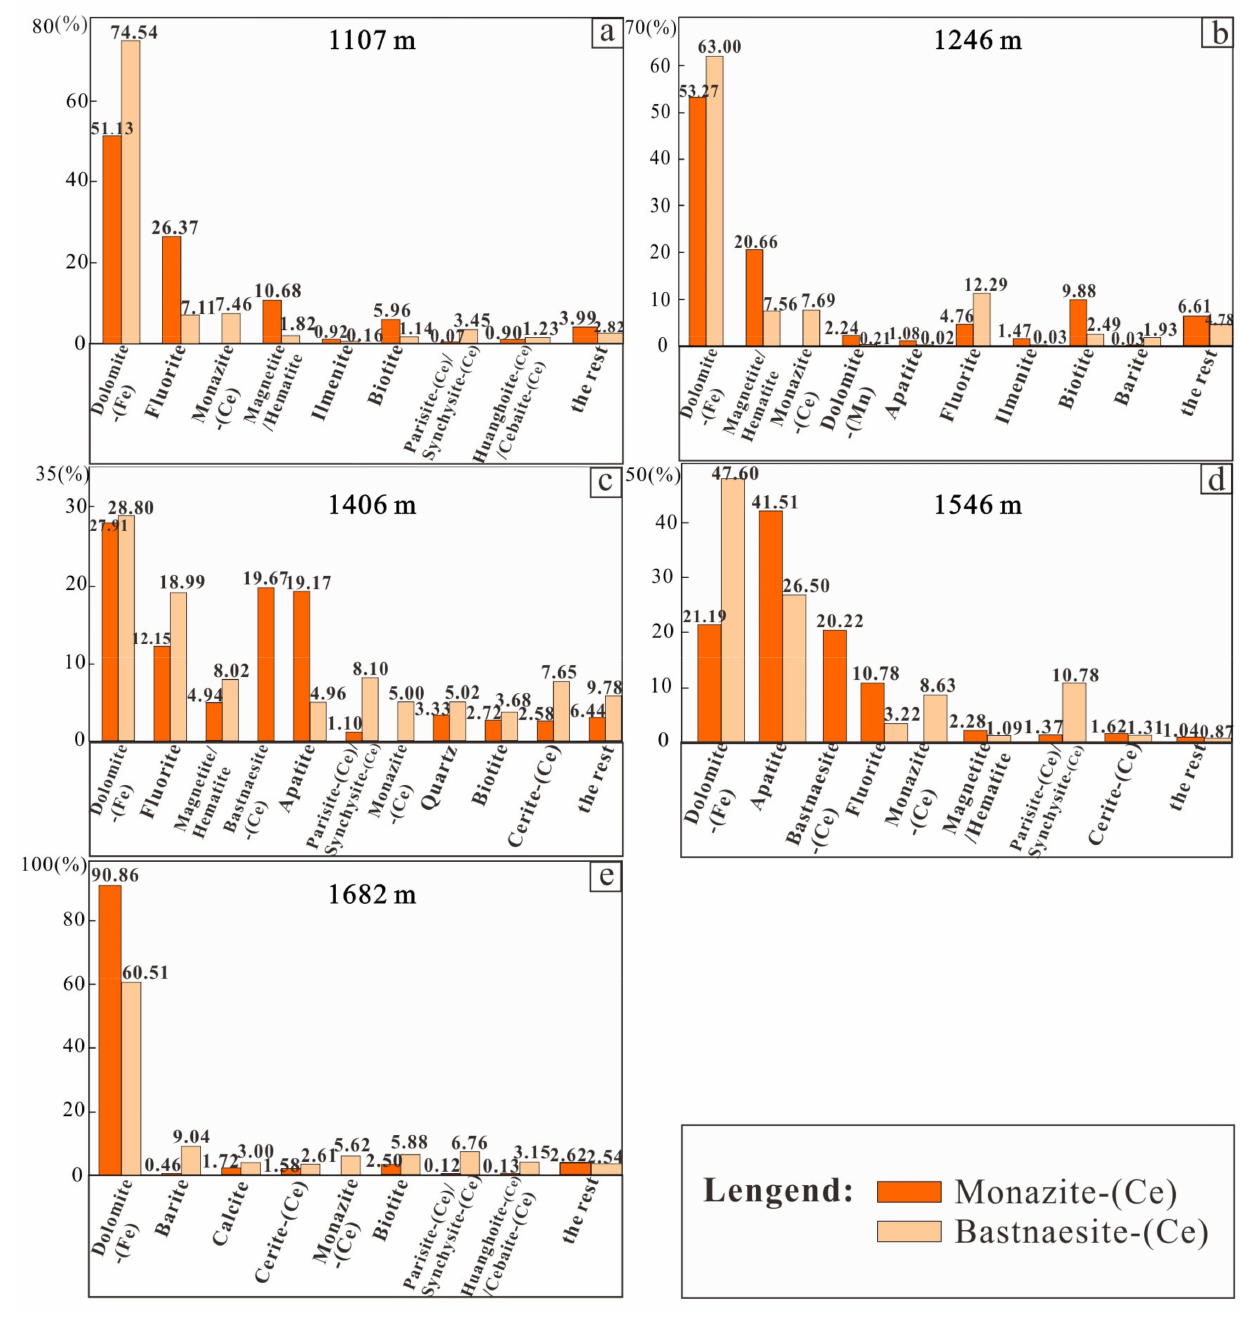
Figure 4. The TIMA calculated the mineral association percentage of monazite-(Ce) and bastnäsite- (Ce) in the studied drill ores from the Bayan Obo deposit. ( a ) mineral association percentage of monazite-(Ce) and bastnäsite-(Ce) of sample 1107 m; ( b )mineral association percentage of monazite- (Ce) and bastnäsite-(Ce) of sample 1246 m; ( c ) mineral association percentage of monazite-(Ce) and bastnäsite-(Ce) of sample 1406 m; ( d ) mineral association percentage of monazite-(Ce) and bastnäsite- (Ce) of sample 1546 m; ( e ) mineral association percentage of monazite-(Ce) and bastnäsite-(Ce) of sample 1682